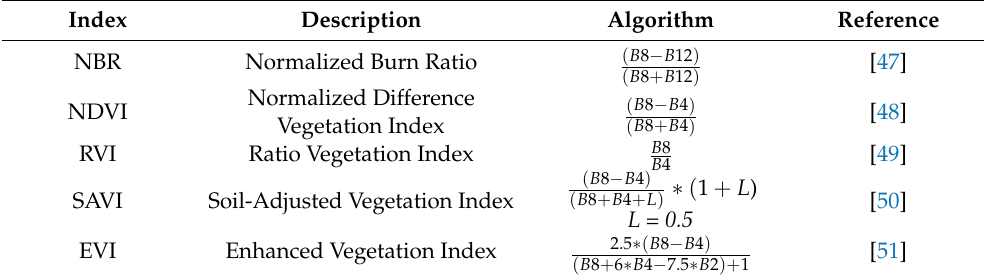
Table 3. Sentinel-2 spectral indices used in the